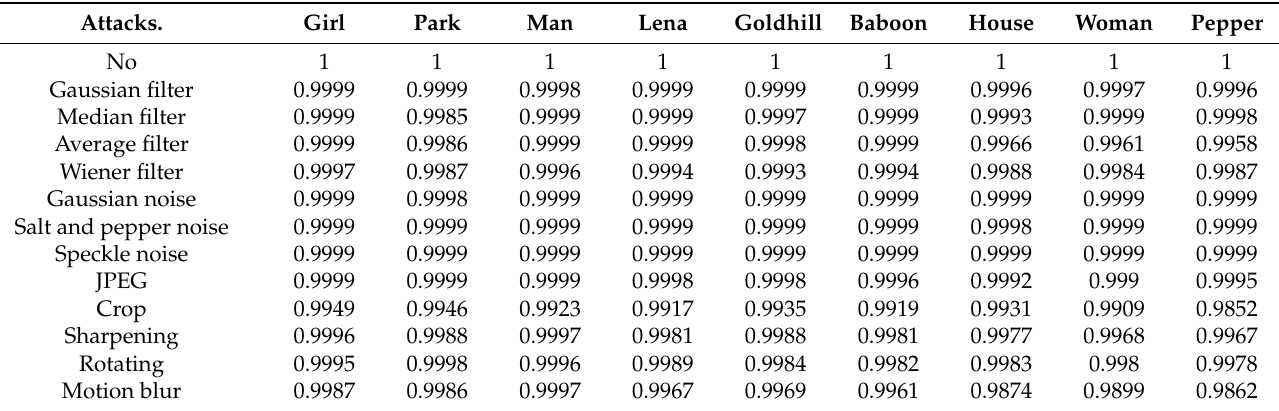
Table 2. NC values after various